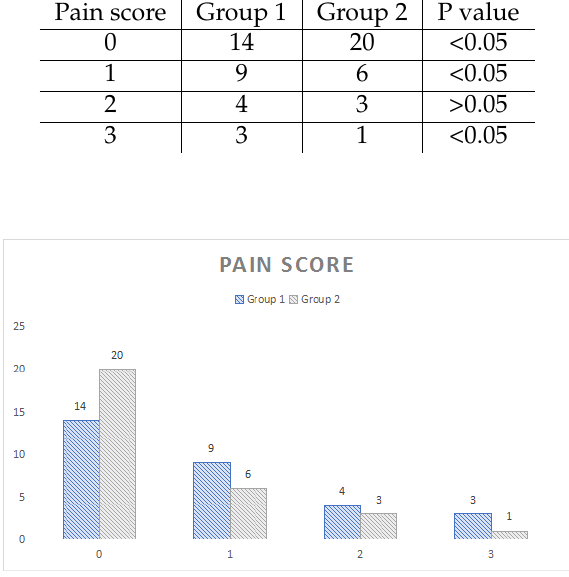
Table 2. Comparison of pain score between both groups